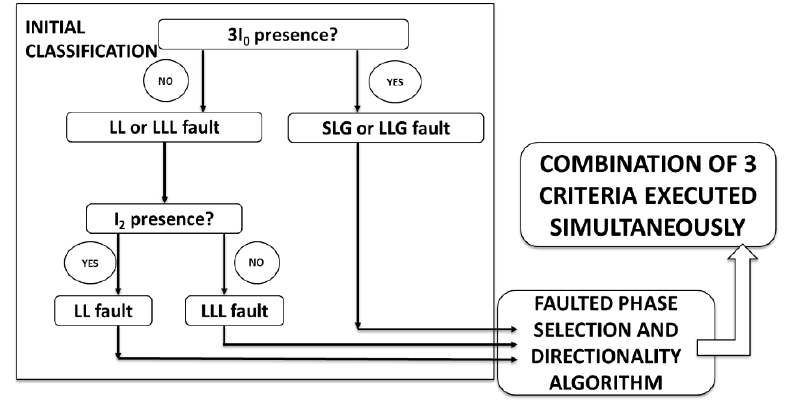
Figure 9. Initial fault classification.